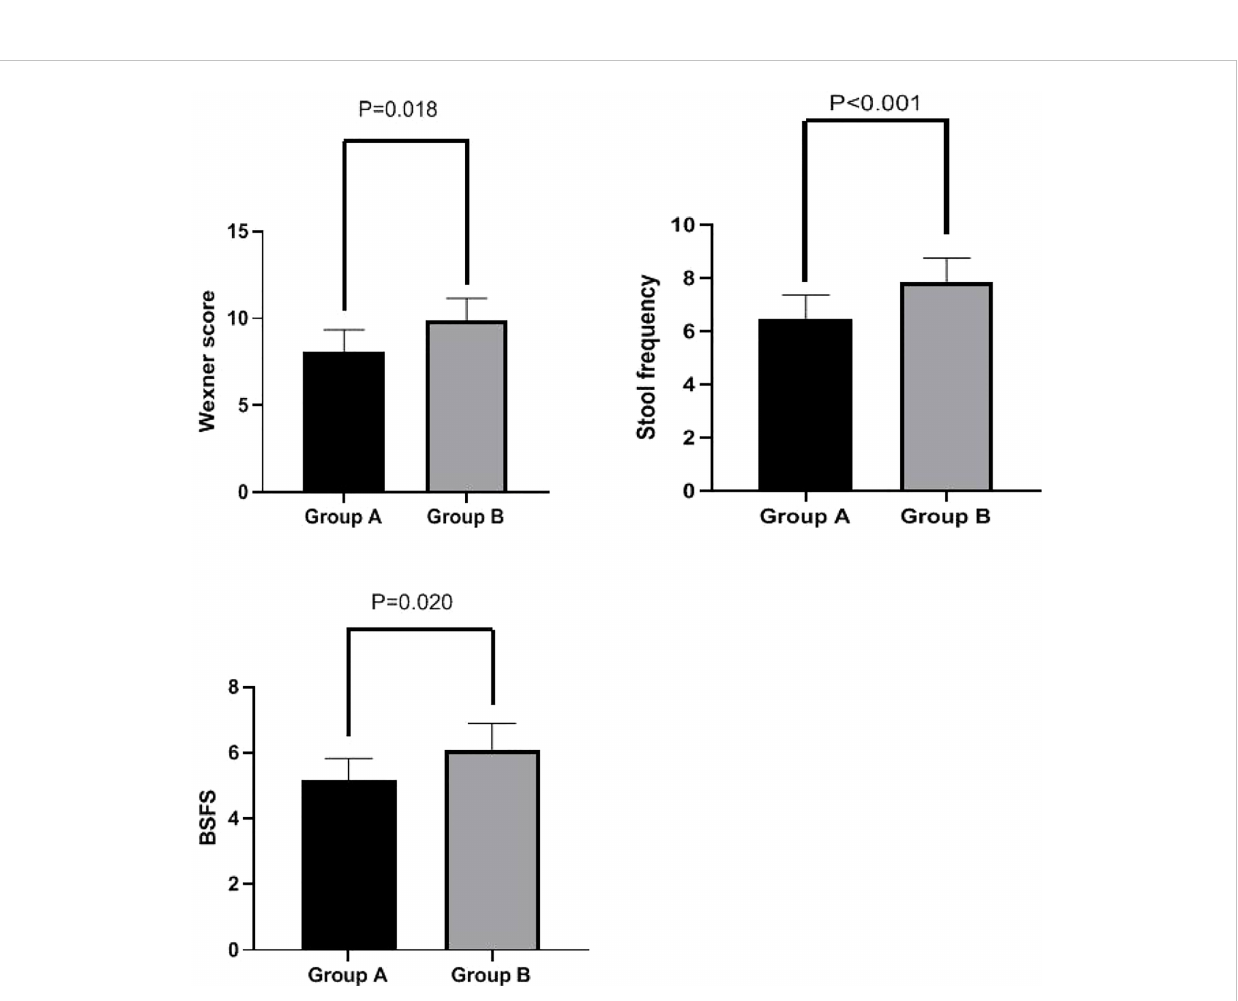
FIGURE 3 Wexner score, stool frequency, and BSFS score in Groups A and B at week 4. Wexner scores were signi fi cantly lower in Group A than in Group B at week 4 (8.10 ± 1.24 vs. 9.87 ± 1.29 ml, p = 0.018). Stool frequency (6.47 ± 0.90 vs. 7.83 ± 0.93, p < 0.001) and BSFS scores (5.17 ± 0.65 vs. 6.10 ± 0.80, p = 0.020) were also signi fi cantly lower in Group A than in Group B at week 4. BSFS, Bristol Stool Form